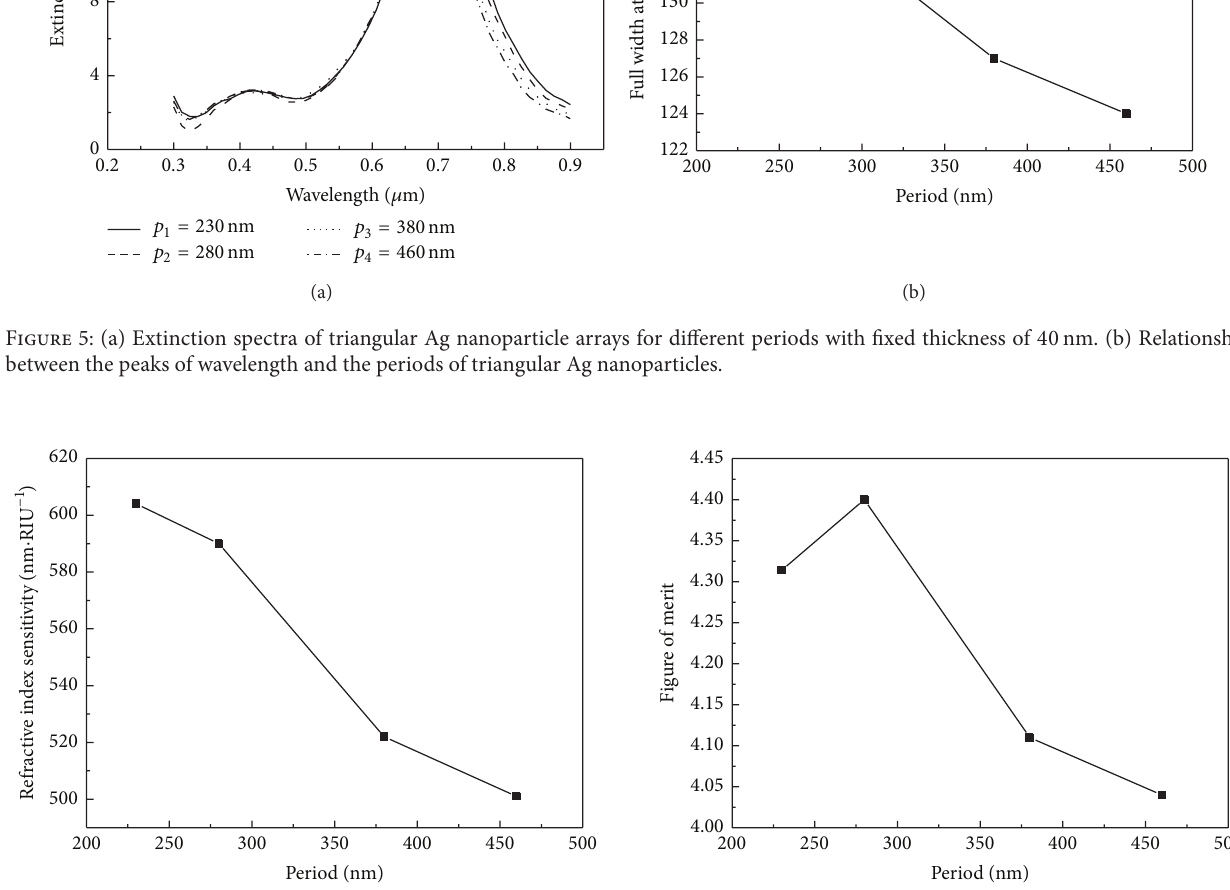
Figure 7: Figure of merit of the triangular Ag nanoparticle arrays with different periods.